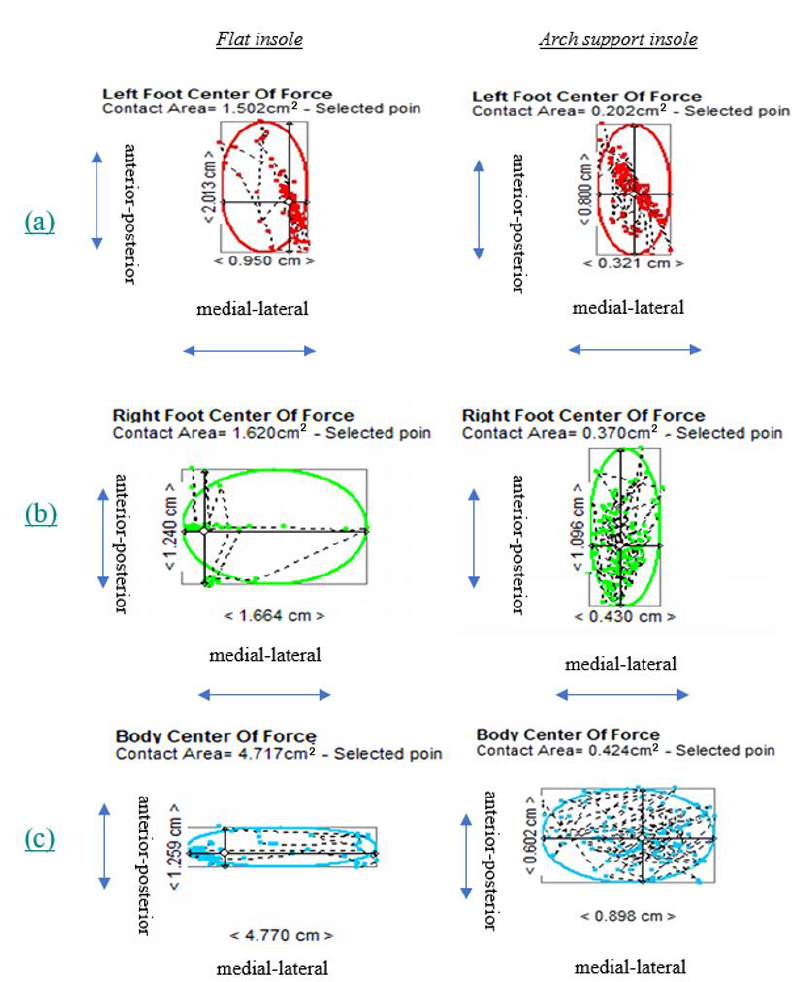
Figure 3. The CoP of the ( a ) left foot (red color), ( b ) right foot (green color), and ( c ) both feet (blue color) in the flat insole ( left ) and arch-support insole ( right ) of a subject. Numbers aligned with vertical axis denote anterior – posterior excursion; numbers aligned with horizontal axis denotes medial – lateral excursion.